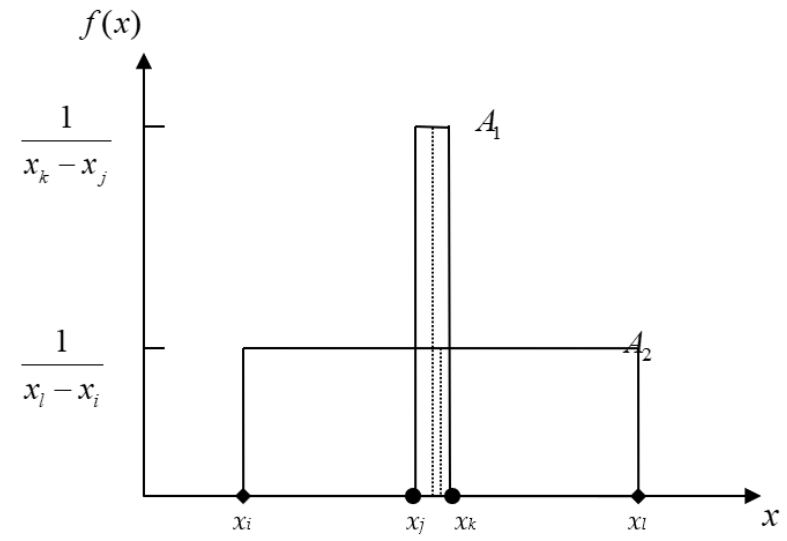
Figure 1. The conflicting situation in precise